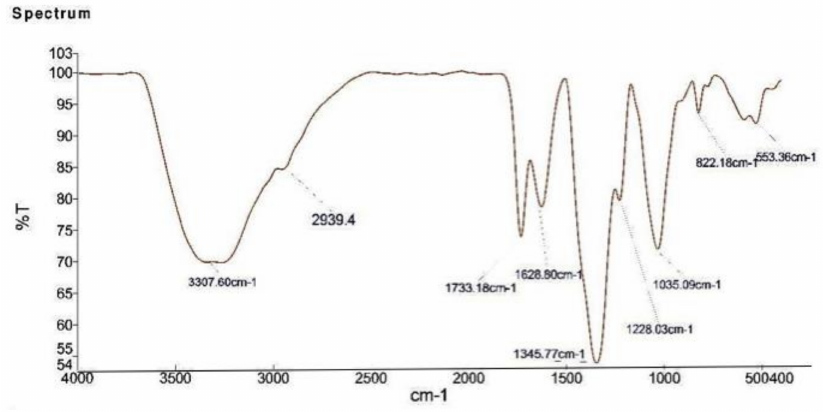
Figure 4. FTIR spectrum of the biosynthesized AgNPs.